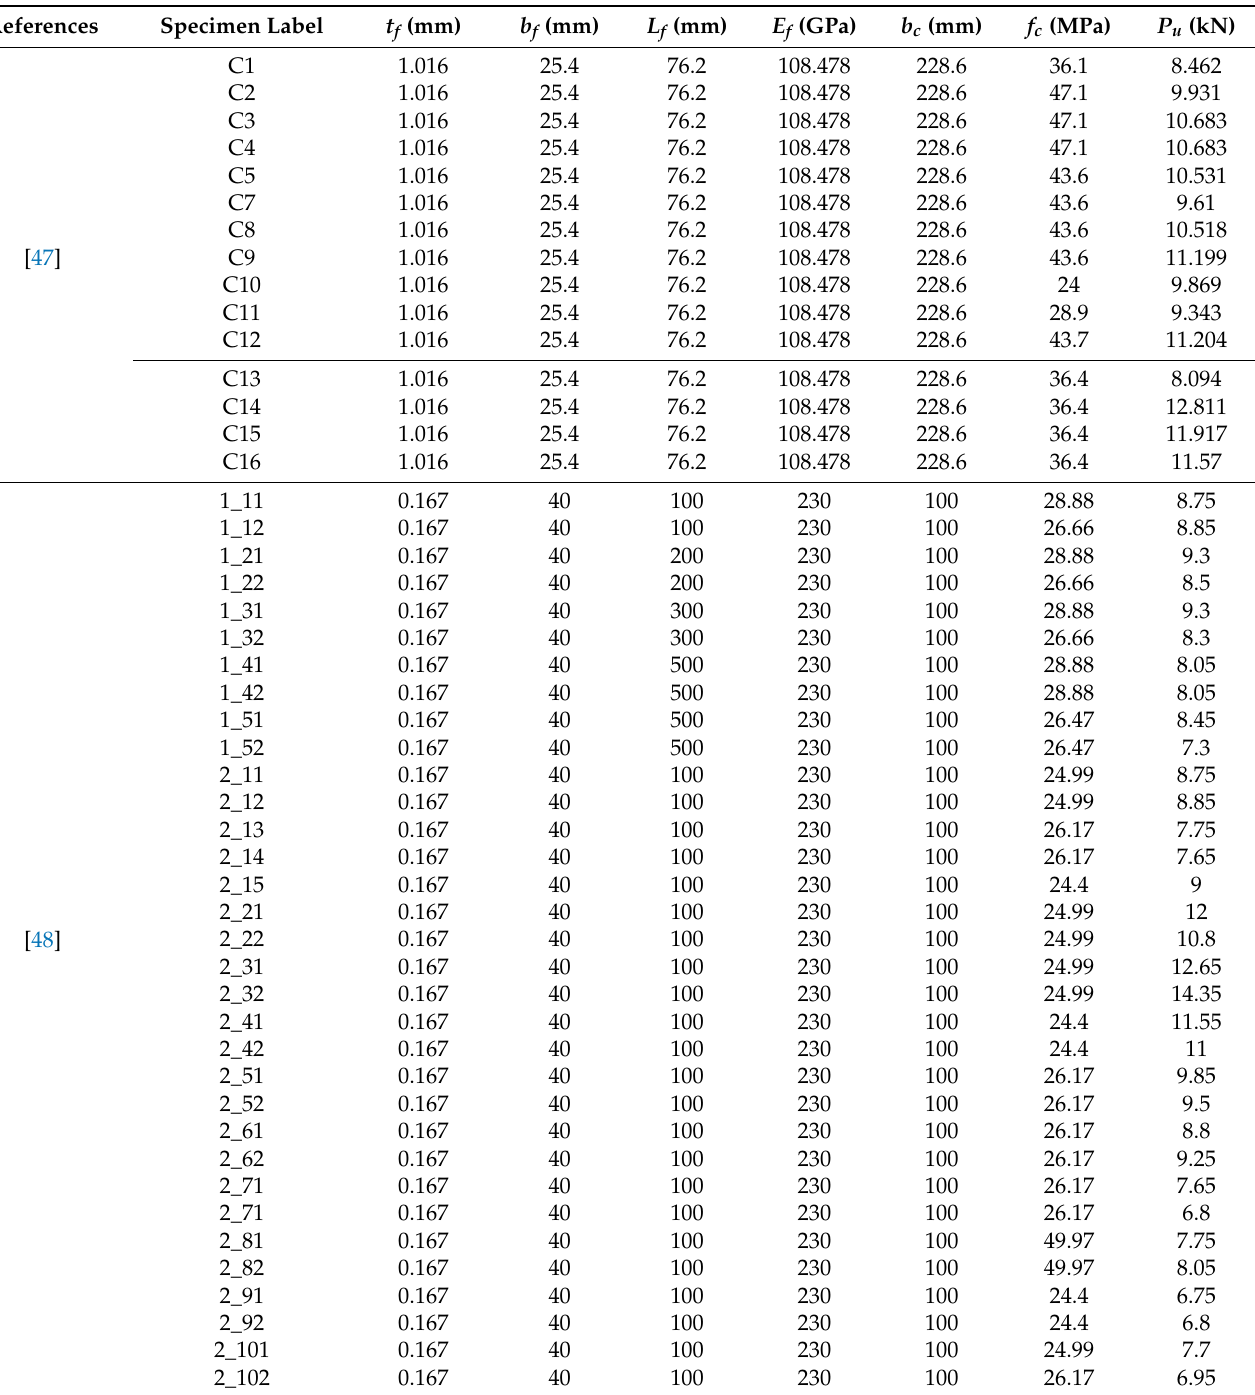
Table A1. Database of FRP-plate vs. concrete substrate bond